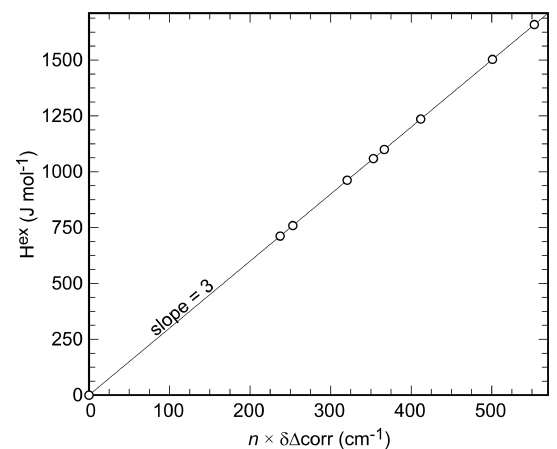
Figure 6. Correlation of H ex and the δ(cid:49) corr values determined for the olivenite–libethenite samples in this study; n is the number of the atoms in the formula unit, in this case 9. The line shown is not a fit to the data, but it is rather a line with an exact slope of